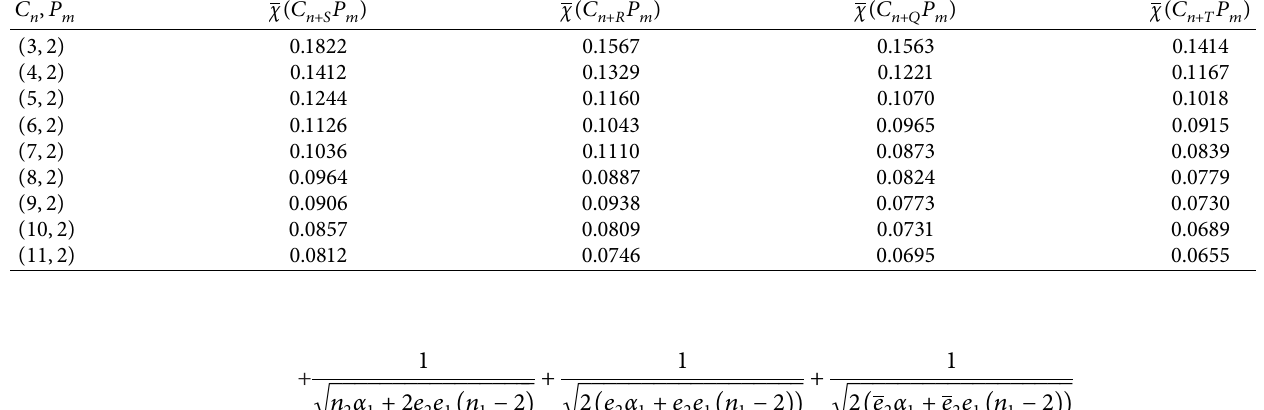
Table 1: Sum-connectivity coindex for certain F -sum